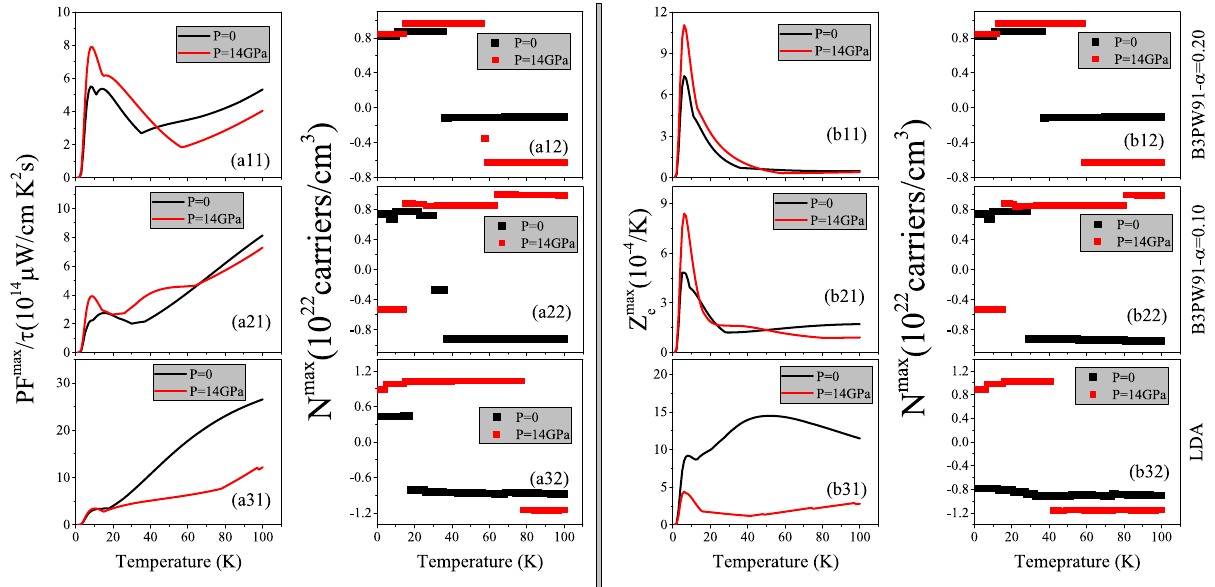
Figure 7. ( ai1 ) Maximum values of spin up power factor per relaxation time, PF max /τ , versus temperature calculated using B3PW91 with α = 0.20, 0.10 and LDA for the P = 0 and 14 GPa pressures. ( ai2 ) Doping 2 levels related to the PF max /τ . ( bi1 ) Maximum values of spin up electronic figure of merit, Z max e = σ S κ e , versus temperature calculated using B3PW91 with α = 0.20,0.10 and LDA for the P = 0 and 14 GPa pressures. ( bi2 ) Doping levels related to the Z max e . The i-index varies from 1 to 3. In the AFM phase, spin down results are the same as spin up PF max /τ . As shown in Fig. 7a11, the high localized B3PW91- α = 0.20 XCF predicts that PF max /τ occurs at very low temperatures (T ≃ 10 K) and P = 0. This peak is also seen in the B3PW91- α = 0.10 XCF and P = 0. However, the value of this peak using α = 0.10 is considerably lower than α = 0.20. If we use the low localized LDA XCF, the peak of PF max /τ at low temperatures completely disappears. Our results show that PF max /τ increases monotoni- cally as temperature increases using LDA XCF, as shown in Fig. 7a31. Comparing the results of different XCFs reveals that the effect of the localization degree on the PF max /τ is temperature dependent. At very low tempera- tures, i.e., around T = 10 K, the reduction of the localization degree makes PF max /τ worse. However, this effect is reversed and the PF max /τ is improved by the reduction of the localization degree as temperature increases. Comparing the Fig. 7ai2 for i = 1–3 reveals that at fixed pressure, the doping levels related to PF max /τ depend on the used XCFs, too. As shown in Fig. 7ai2, for very low temperatures the hole doping leads to the PF max /τ at zero pressure using the considered XCFs, but the value of doping levels depends on the used XCFs. The Fig. 7ai2 also show a gap in the doping levels as temperature increases and thereby the type of the doping levels is changed to electron. This result is independent of the used XCFs. However, the values of the electron doping levels and the gap as well as the temperature (where this gap occurs) depend on the used XCF. The PF max /τ can be also affected by pressure. Based on our calculations using B3PW91 XCF with α = 0.20 ( α = 0.10), applying pressure improves PF max /τ for temperature lower than T ≃ 45 K (T ≃ 70 K ), while makes it worse for higher temperatures. The same result is obtained using LDA, but at T ≃ 12 K; applying pressure improves PF max /τ for temperature lower than T ≃ 12 K, while makes it worse for higher temperatures using LDA. Interestingly, the value of improvement or deterioration of PF max /τ due to applying pressure is strongly XCF dependent. We also see that the effect of pressure on the doping levels is strongly XCF dependent, see Fig. 7ai2 for i = 1–3. These results are in complete accord with our previous results 47 . In addition to the constant τ model, we calculated the PF max /τ using the Model1 and Model2. The results is presented in Fig. 8a. The same as conductivity parameters, the PF max /τ calculated by Model2 is considerably greater than that calculated by Model1 in order of magnitude at all the considered temperature ranges, as shown in Fig. 8a. This figure also shows that there is a peak in PF max /τ calculated by the two considered models at very low temperatures. The comparison of Figs. 8a and 7a11 reveals that the behavior of PF max /τ calculated by Model1 and Model2 is very similar to that calculated by the constant τ model, however, its orders of magnitude as predicted by Model1 and Model2 are significantly more than that predicted by the constant τ model. In fact, the efficiency of thermoelectricity depends on both PF and thermal conductivity. As stated above, we only calculate the electronic part of thermal conductivity, i.e., κ e , here. This means that the calculated figure 2 of merit, Z , is not exact. Therefore, we introduce the electronic figure of merit as Z e = σ S κ e to emphasize that the lattice portion of thermal conductivity is neglected. It is obvious that Z e and Z are not exactly the same as each other. However, in metals the lattice part is very small and can be safely neglected 82,83 , specifically at low temperatures. Thus, Z e is approximately very close to Z . The (bi1) panels of Fig. 7 display the maximum values of Z e , i.e., Z max e versus temperature using the aforementioned XCFs and pressures. The (bi2) panels show the doping levels related to Z max e . As the Fig. 7b11 reveals, the B3PW91 XCF with α = 0.20 predicts a remarkable